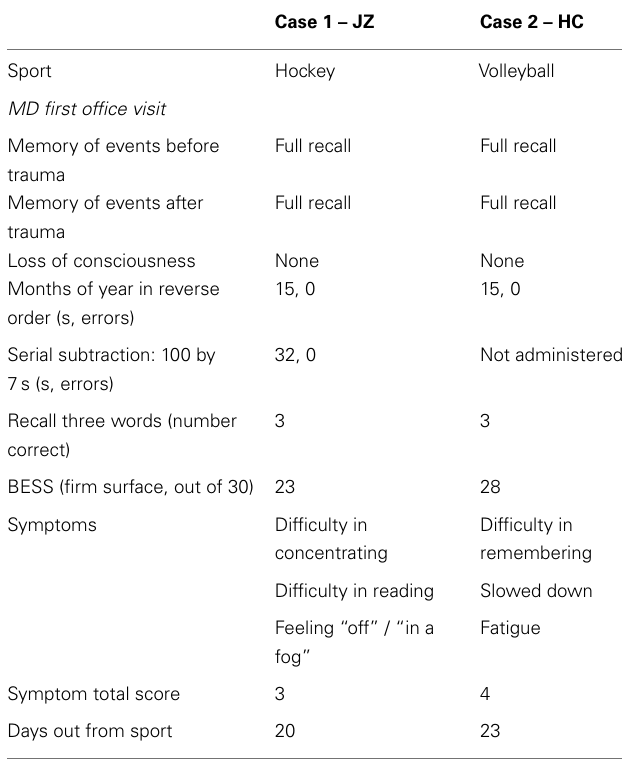
Table 1 | Summary of clinical cases